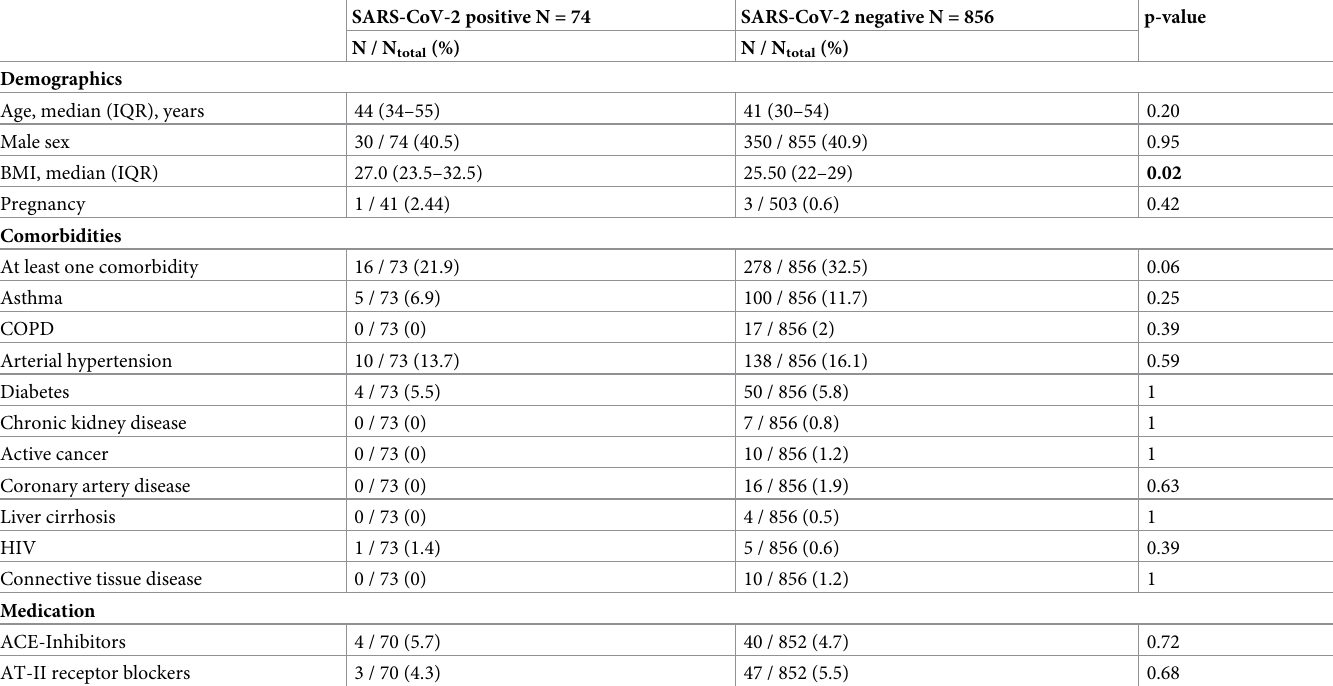
Table 1. Demographics and comorbidities for patients with and without